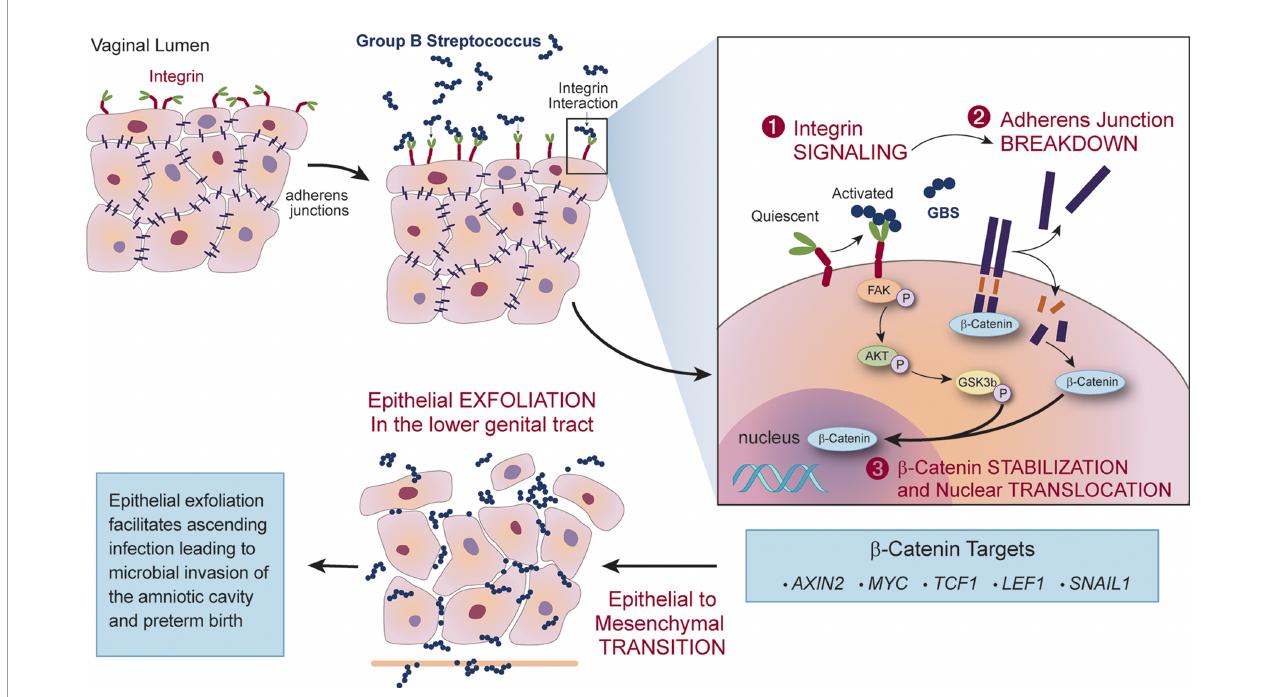
FIGURE 3 | GBS exploits epithelial-mesenchymal transition (EMT) and vaginal epithelial exfoliation to permit ascending infection. During vaginal infection, GBS binds integrins on the epithelial surface and activates integrin signaling that results in the breakdown of adherens junctions. Displaced b -catenin translocates to the nucleus, activating transcriptional changes of b -catenin targets associated with EMT. Expression of these transcripts in vivo leads to vaginal epithelial exfoliation, which facilitates GBS ascension to the uterus and is associated with increased risk for microbial invasion of the amniotic cavity and preterm